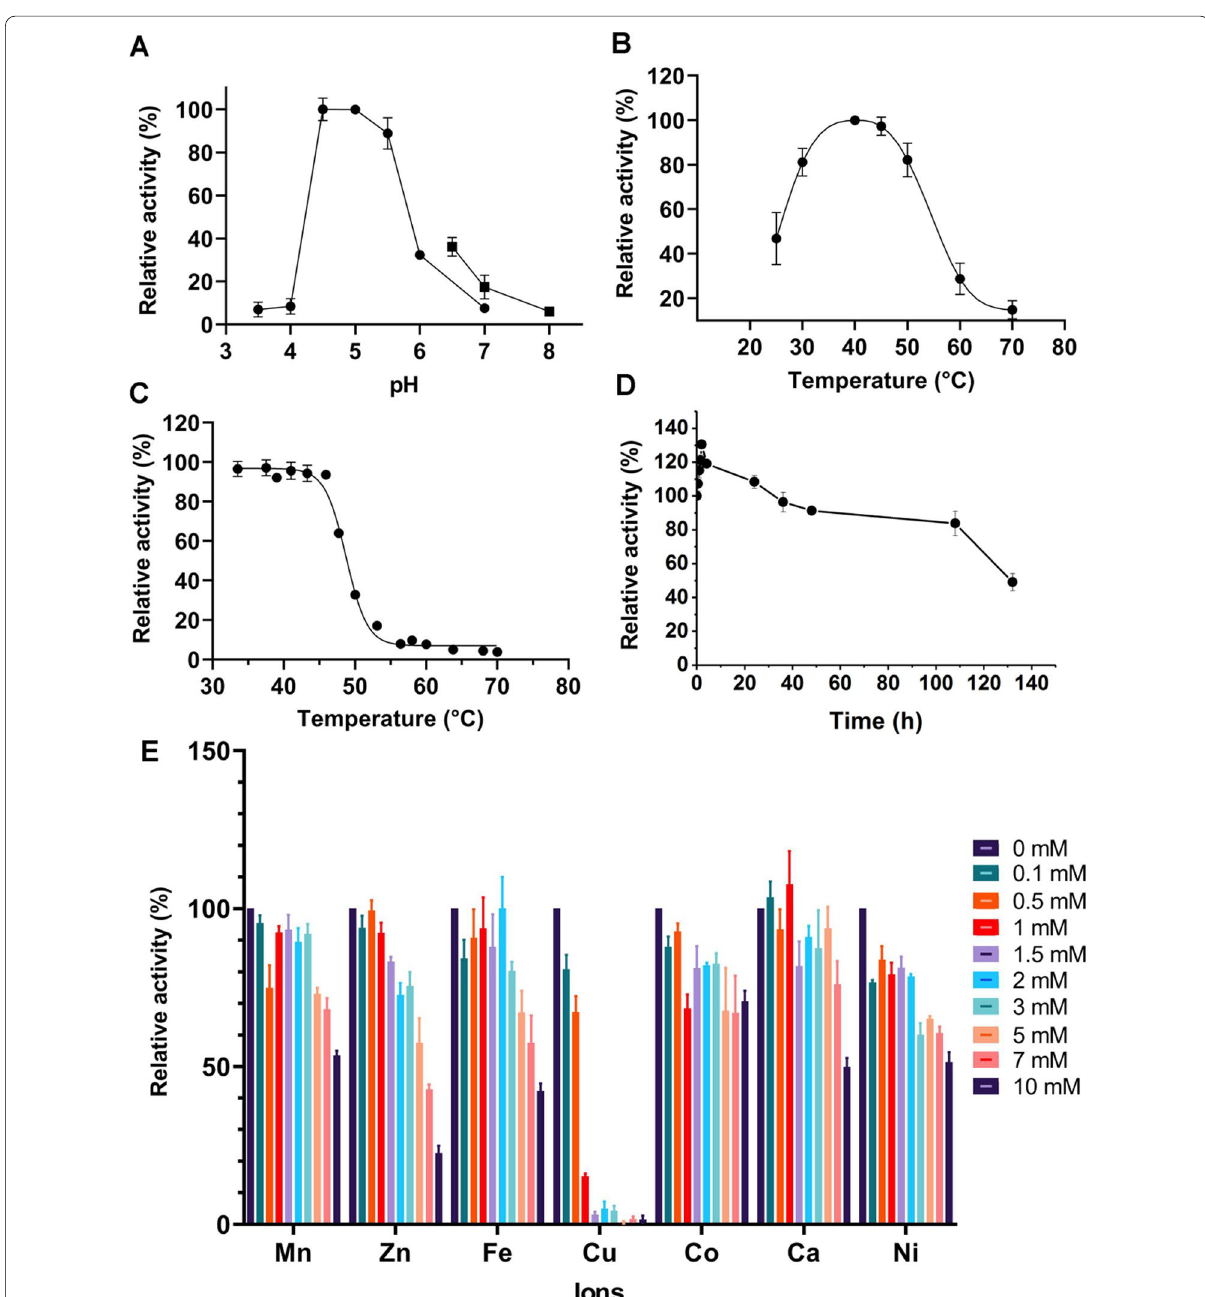
Fig. 4 Biochemical characterization of C25GH19B. A The pH-activity profile of C25GH19B. The activity was determined in 50 mM citric—phosphate buffer ( ● ) in the range of pH 3.5–7.0 and 50 mM phosphate buffer ( ■ ) in the range of pH 6.5–8.0. B The temperature-activity profile of C25GH19B. C Thermal inactivation of C25GH19B incubated at different temperatures for 15 min. The enzyme protein in 50 mM acetate buffer (pH 5.0) was incubated at various temperatures for 15 min and assayed for residual activity at 30 °C. The activity of the samples without incubation was considered to be 100%. D Thermal inactivation profile of C25GH19B at 40 °C. E The effect of divalent metal ions on the enzyme